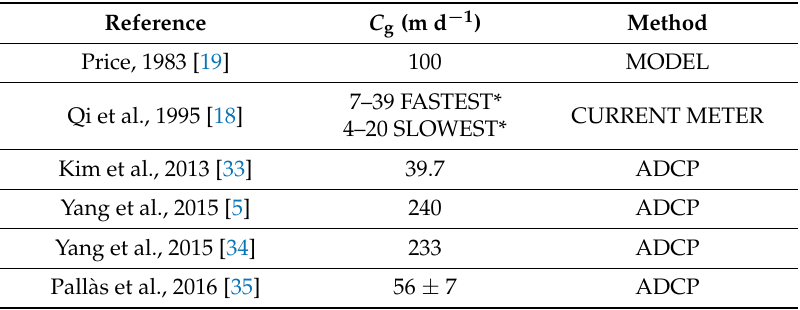
Table 1. Summary of vertical group velocity ( C g ) values found in previous